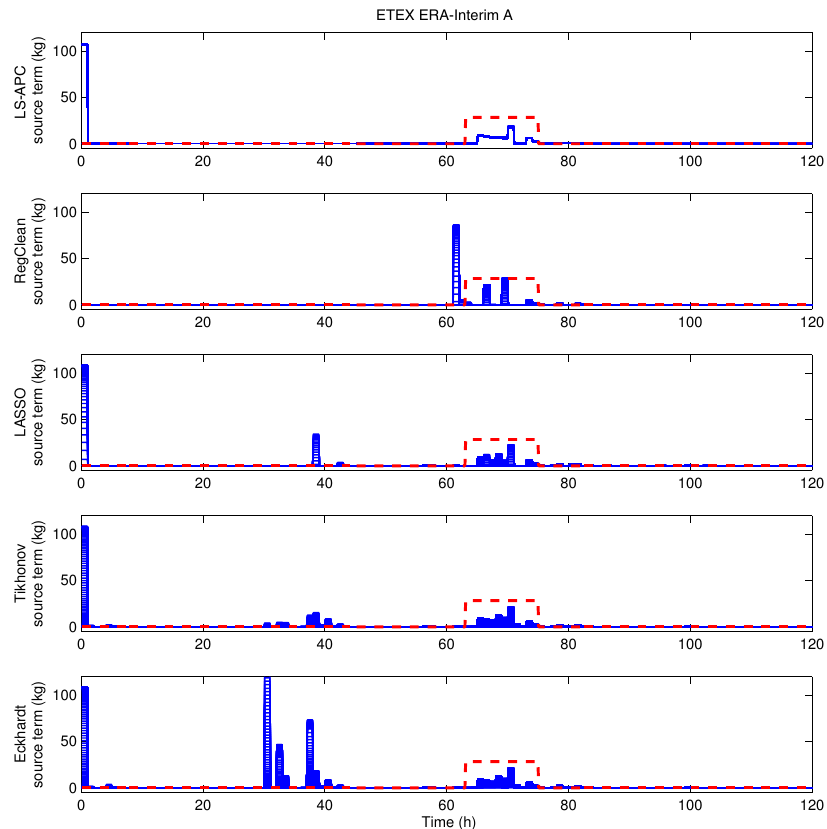
Figure 8. Comparison of the estimated source term for data ETEX ERA-Interim A for all settings (221 values) of the tuning parameter α using all algorithms. For LS-APC, all estimates are overlapping; for algorithms sensitive to this choice, the lines for different values of the tuning parameter are plotted next to each other forming an area. The true source term is denoted by the dashed red line.